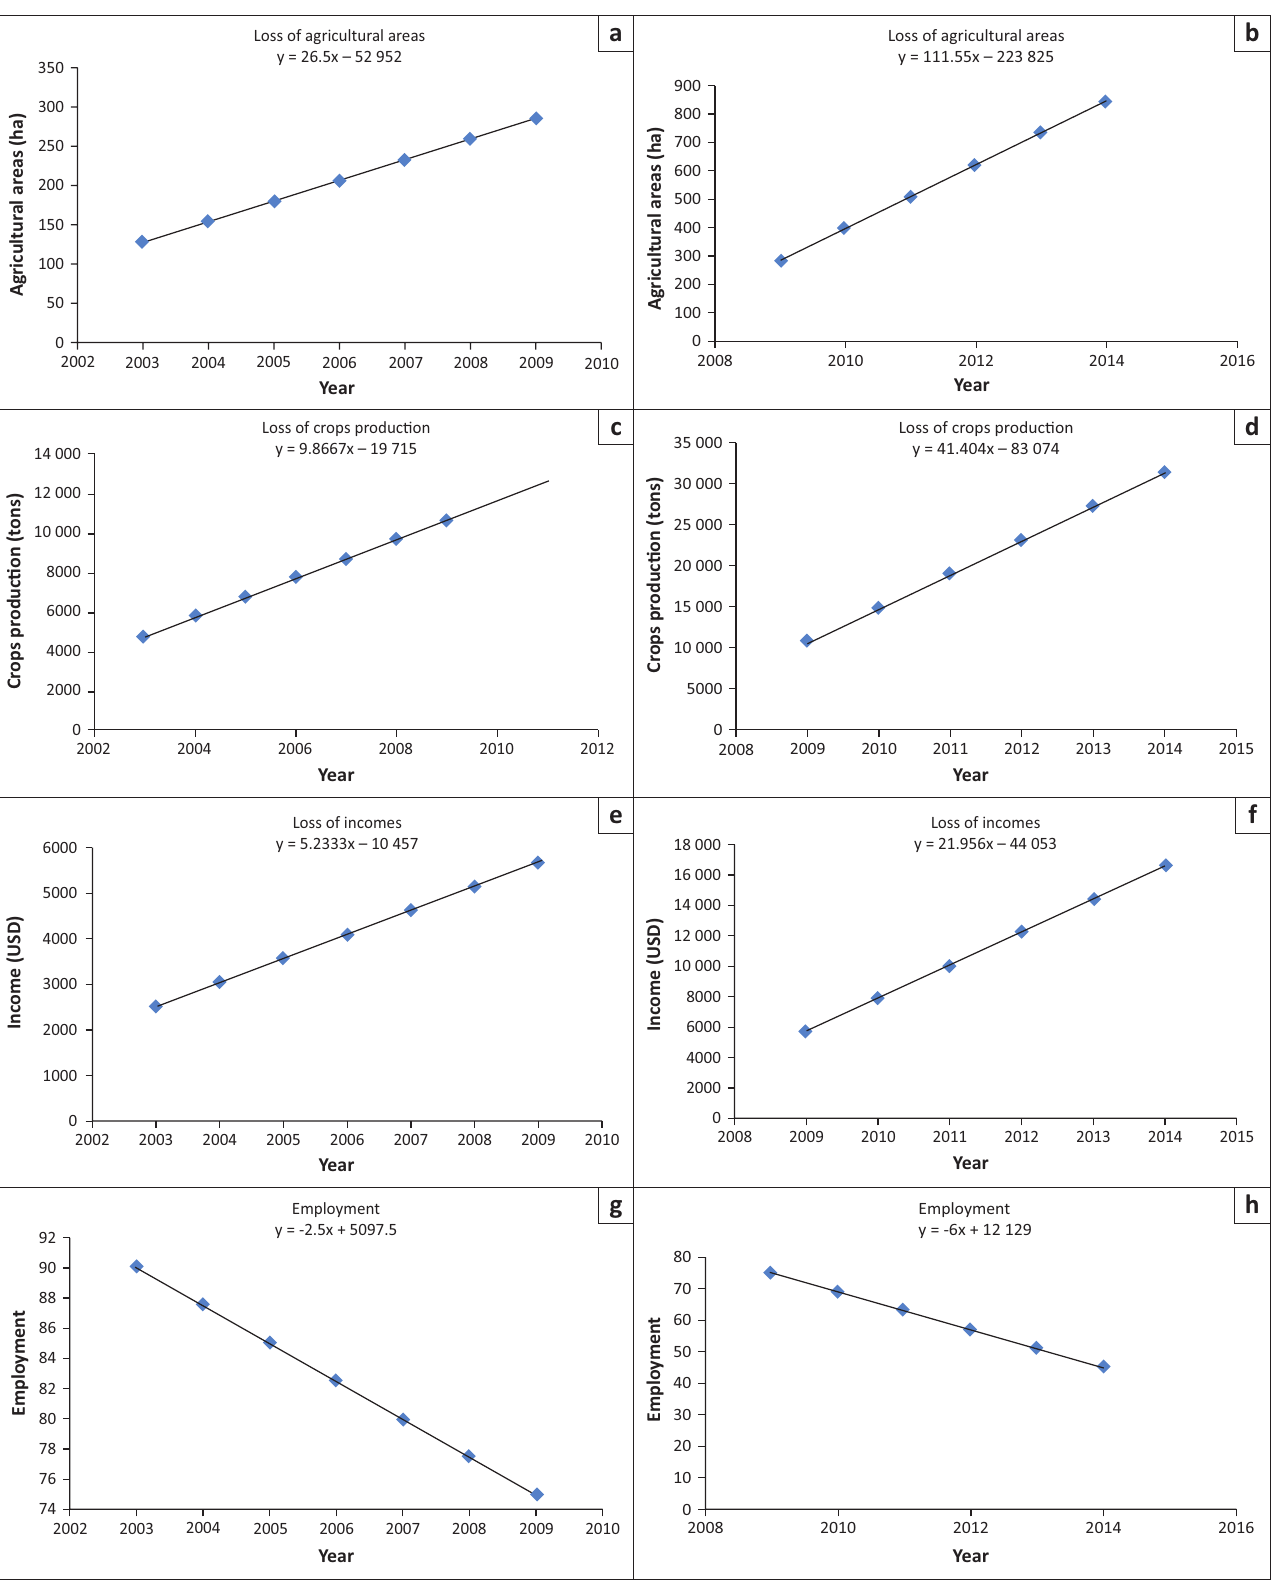
FIGURE 3: Estimation of the input variables for the Classification and Regression Tree model using linear regression. (a) Loss of agricultural areas 2003–2009, (b) loss of agricultural areas 2009-2014, (c) loss of crop production 2003–2009, (d) loss of crop production 2009–2014, (e) loss of income 2003–2009, (f) loss of income 2009–2014, (g) decrease in employment 2003–2009 and (h) decrease in employment